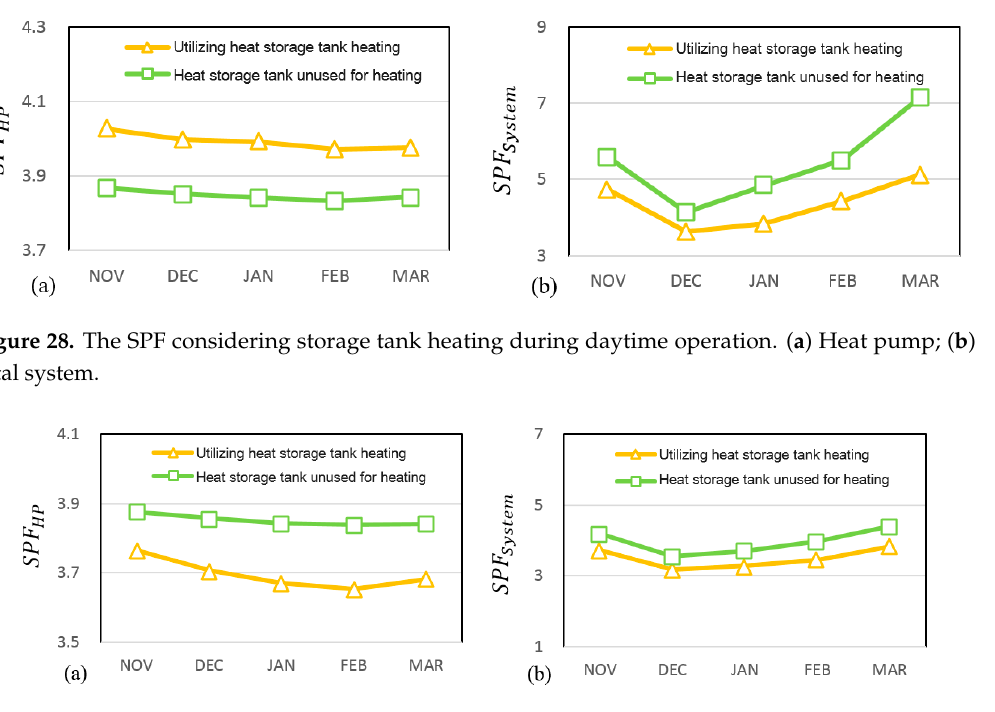
Figure 29. The SPF considering storage tank heating during night time operation. ( a ) Heat pump; ( b ) total system.